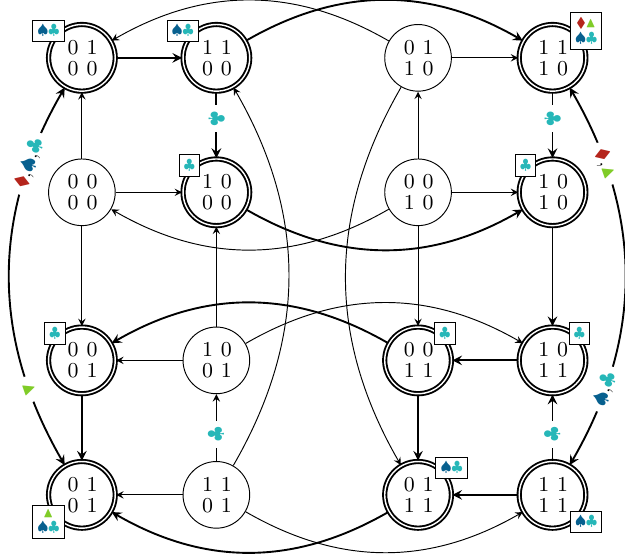
Figure 4. The asynchronous semantics of the ParBN given in Figure 3a, restricted to P = P 2,3,6 : 0, P 1,4,5,7,8 : 1 Here, (cid:7) = { belled edges are enabled for all parametrisations. The highlighted vertices represent attractors for indicated